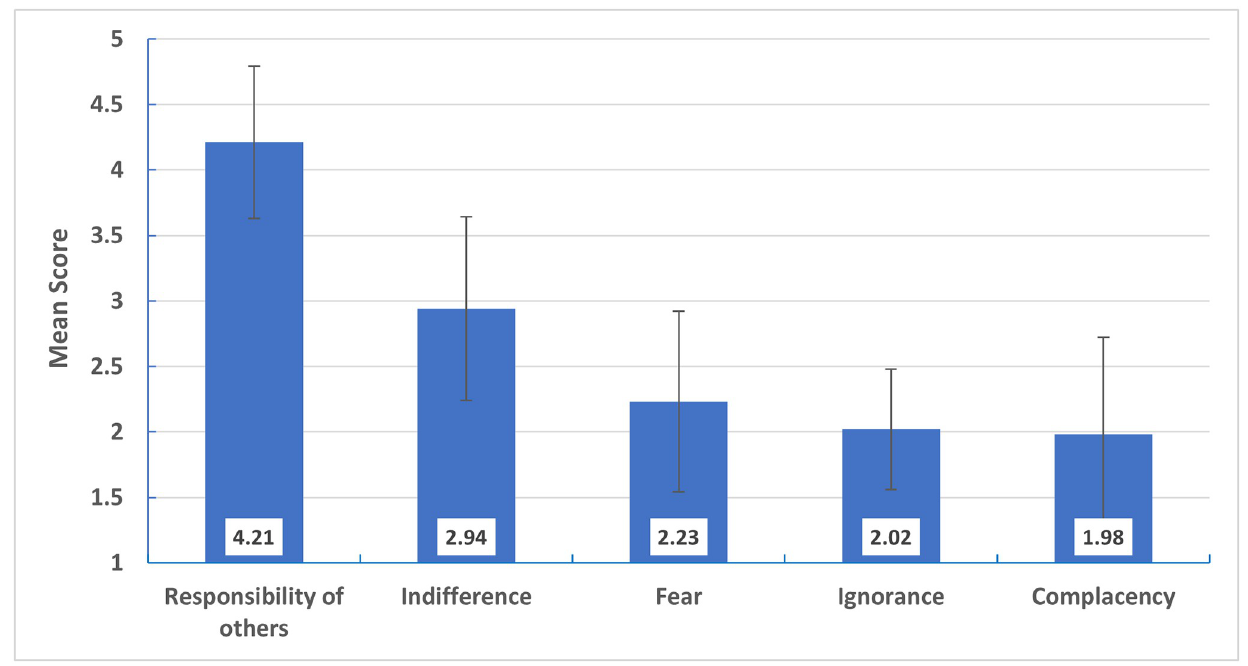
Fig 3. Mean attitudes score for inappropriate antibiotic prescribing. Error bars represent SD.